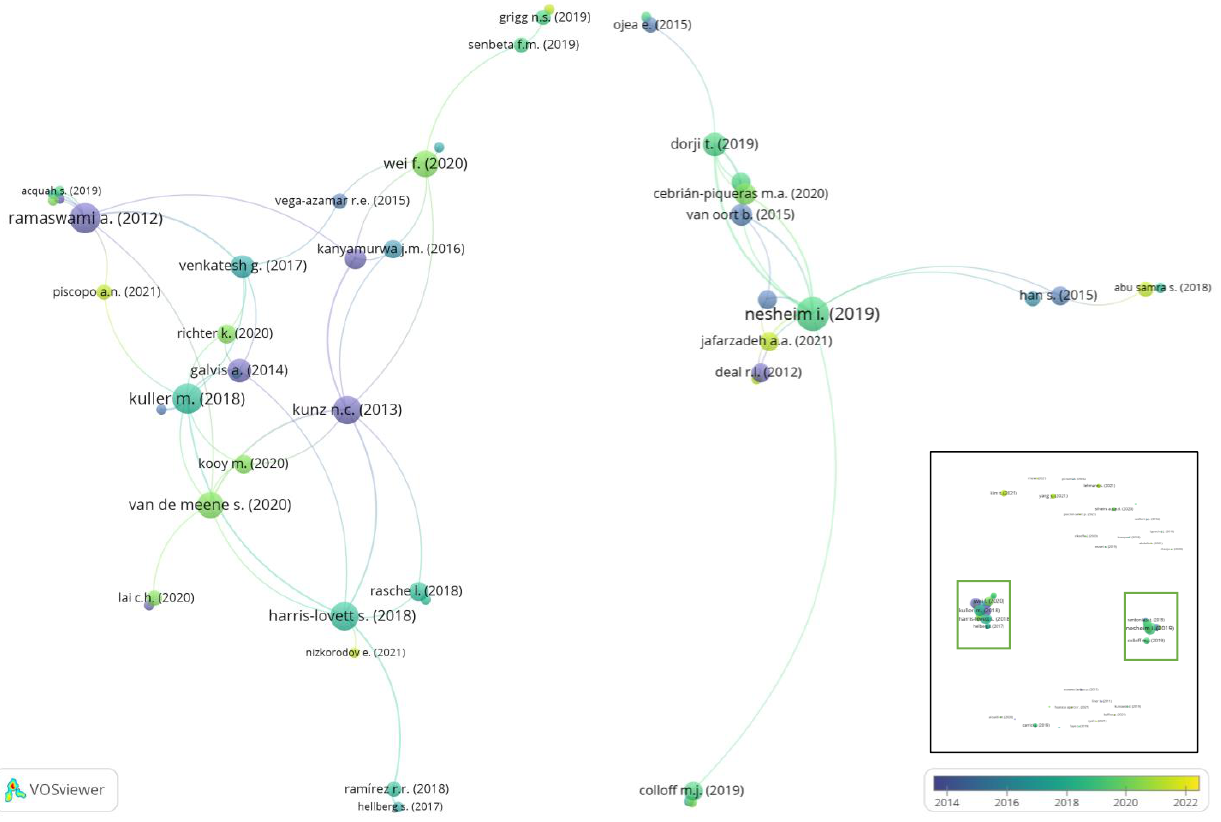
Table 2. Total of papers per research motivation.